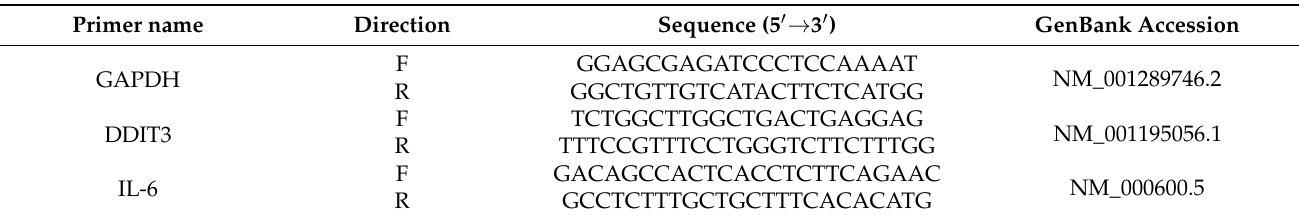
Table 2. Real-time PCR primers used in Caco2